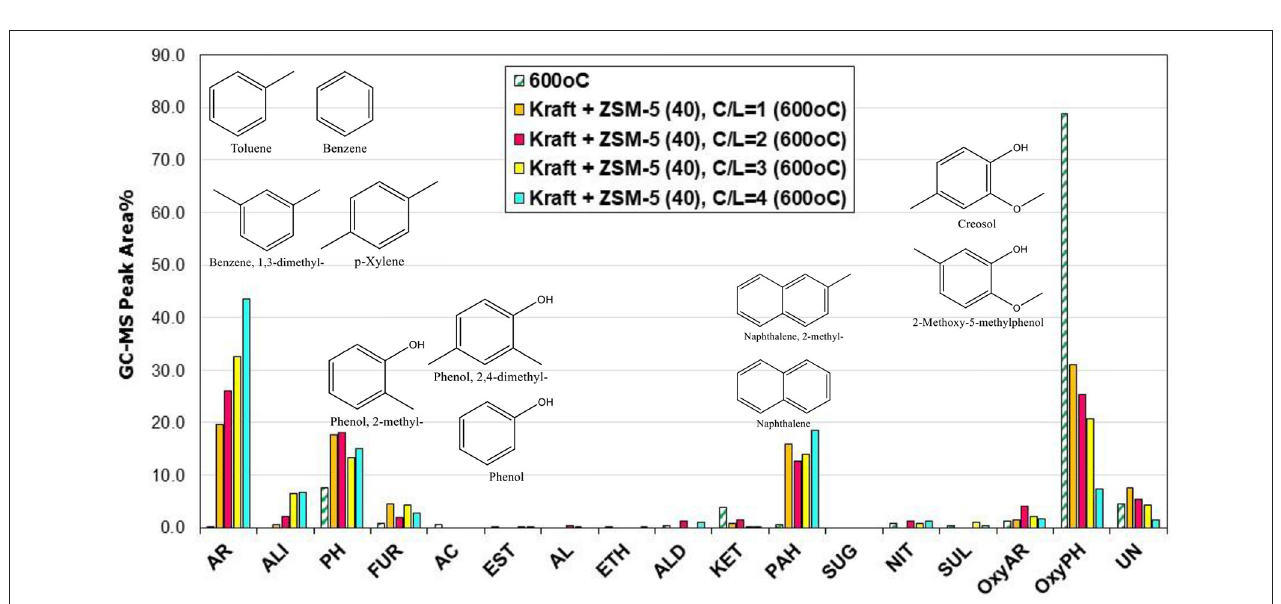
we investigated the effect of Si/Al ratio (11.5, 25, and 40) of ZSM-5 zeolite on the composition of bio-oil via the Py/GC- MS lignin pyrolysis tests. Many studies suggested that when the Si/Al ratios of ZSM-5 decreased and the amount of acid